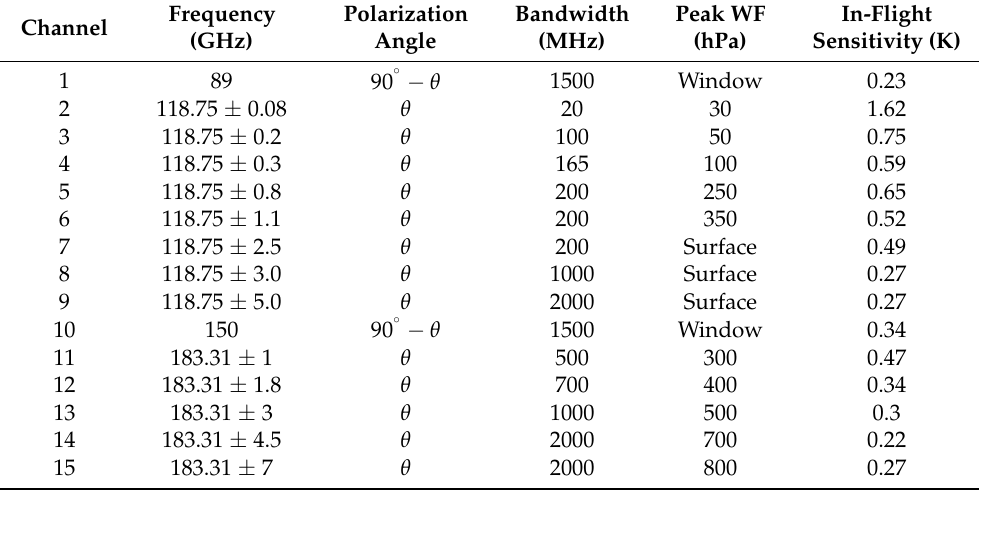
Table 1. MWHTS channel characteristics. WF, weighting function.